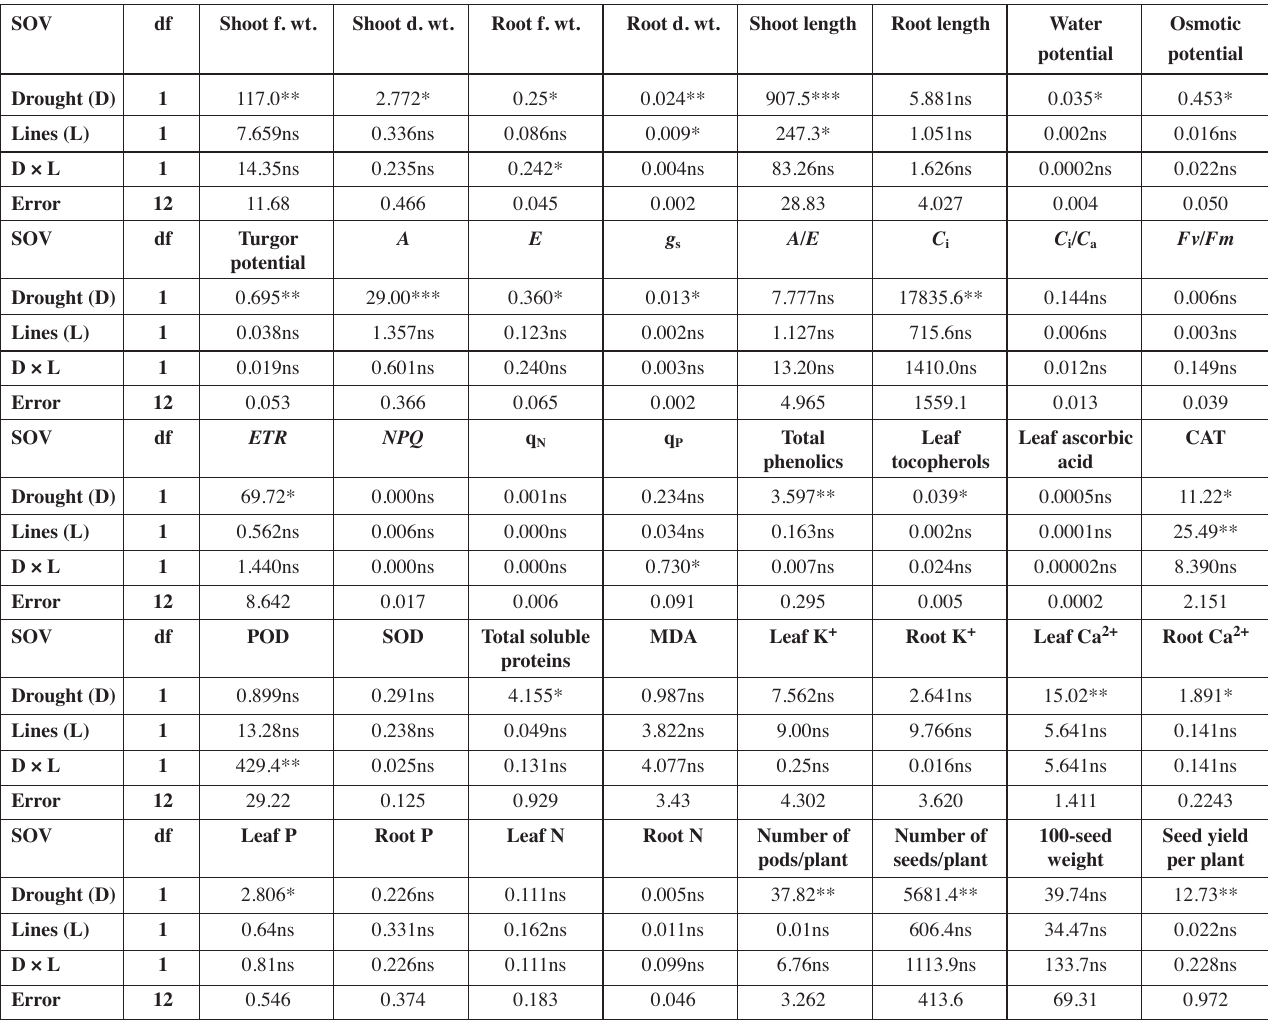
Tab. 1: Mean squares from analyses of variance of data for morphological, physiological, biochemical and yield attributes of mungbean [ Vigna radiata (L.) Wilczek] when 30 day old plants were subjected to drought stress SOV df Shoot f.